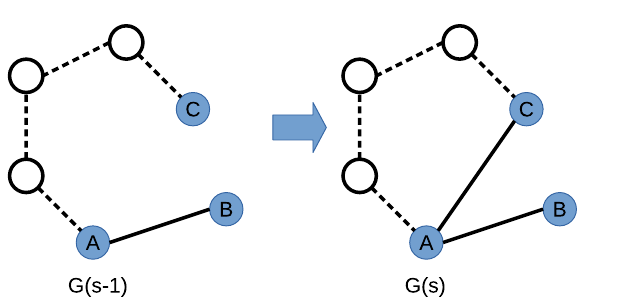
Figure 4. An illustration of how information on long range paths between nodes plays a role in our Triplet Transition method. This shows the evolution of one m 1 triplet in snapshot G ( s − 1 ) to become an m 2 triplet in the next snapshot. The triplet nodes are shown as solid blue circles connected by solid black edges. The network outside the triplet is shown with nodes as open circles connected by edges shown as dashed lines. It is the network outside the triplet which provides a long distance connection between triplet nodes A and C . Within the original ABC triplet in snapshot G ( s − 1 ) , C appears disconnected. By using two snapshots, our transition matrix includes the effects of such long-range links and so this approach can explain why the edge ( A , C ) might be appear more often than otherwise expected from the triplet subgraph